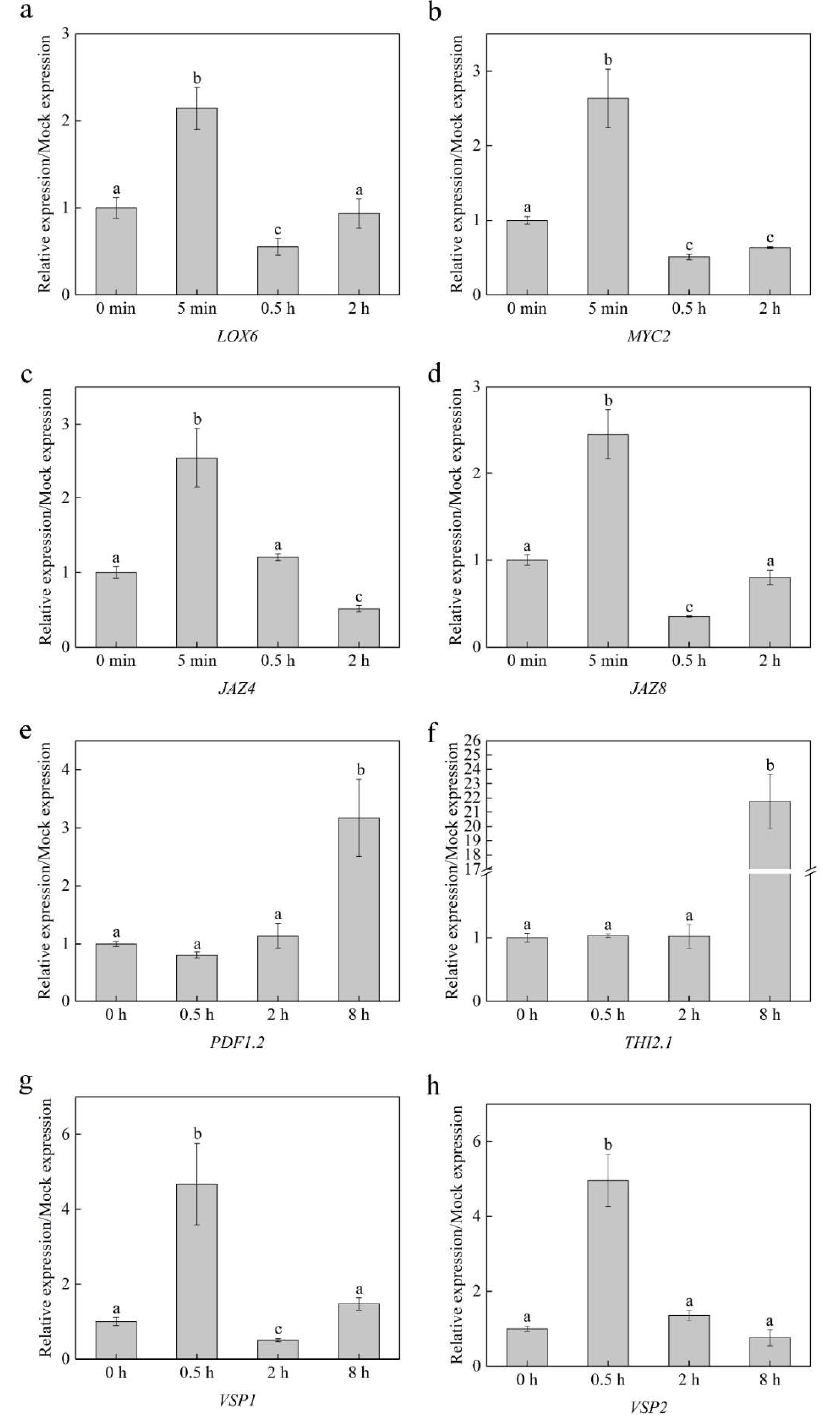
Figure 6. JA-related gene and defense gene expression induced by linalool. ( a – d ) JA-related gene expression in two-week-old Arabidopsis leaves after linalool treatment. The treated times were 5 min, 0.5 h, and 2 h. ( e – h ) Defense gene expression in two-week-old Arabidopsis leaves after linalool treatment. The treated times were 0.5 h, 2 h, and 8 h. Each group has three replicates. Every replicate includes dozens of seedlings ( n ≥ 30), and error bars represent standard error; columns labeled with different letters are significantly different at p < 0.05, Dunnett’s C (variance not neat).